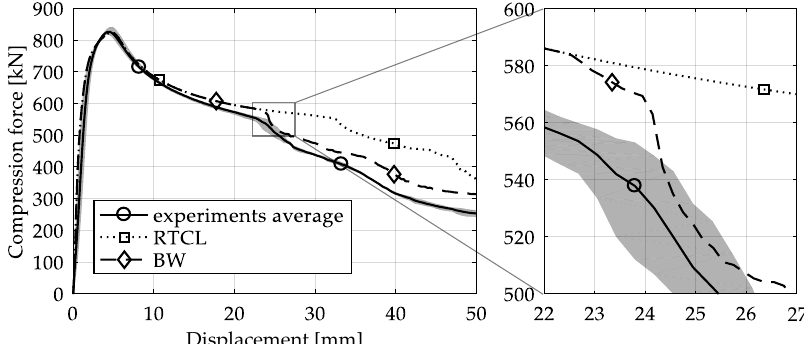
Figure 22. Force – displacement curves of numerical simulated axial compression tests in comparison with the experimental average and its scatter band. The curves ’ progressions at crack initiation is shown in detail on the right.